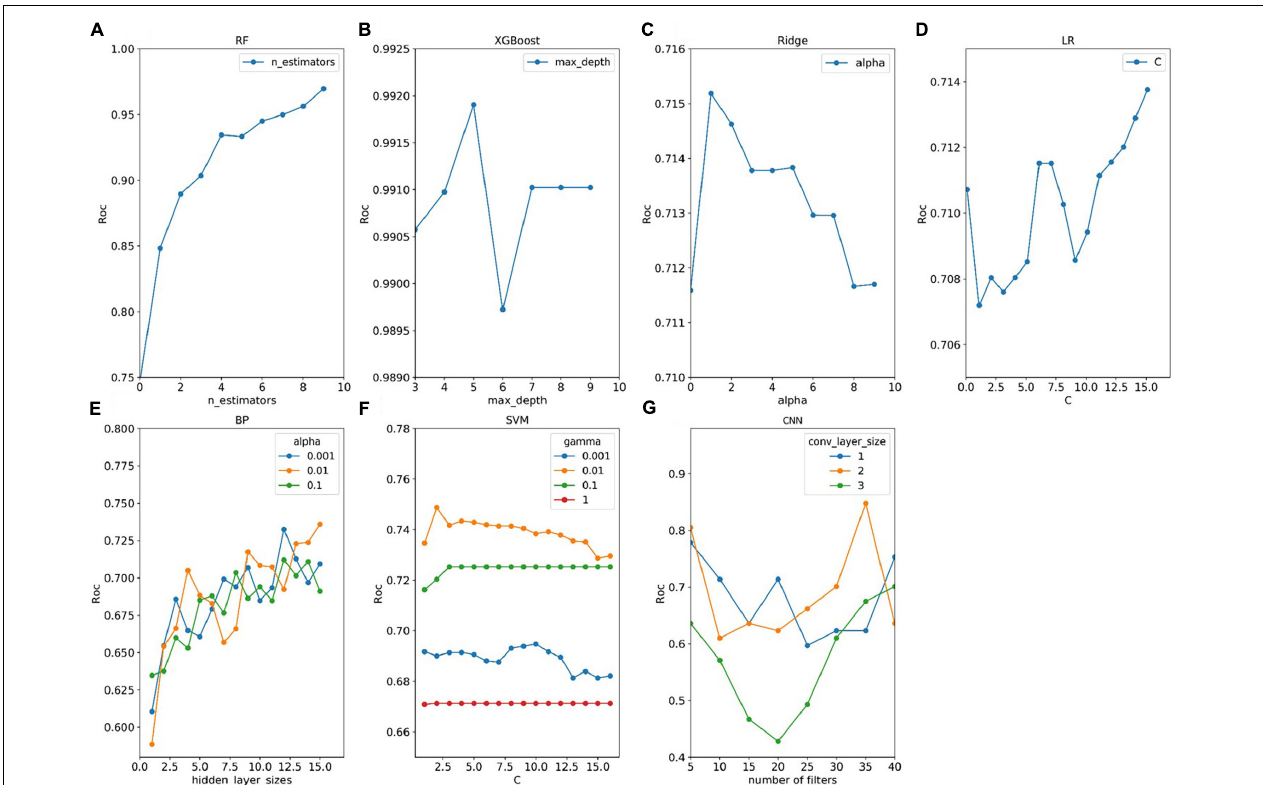
FIGURE 5 | Tuning results of model parameters. (A–G) Four models (RF, XGBoost, Ridge, and LR) have one adjustment parameter, and three models (BP, SVM, and CNN) have two adjustment parameters. For each set of parameters, the model parameters were evaluated for fit using the procedure described in panel Figure 2 . The optimal parameters for each model are selected by obtaining the parameters that the model evaluates to the maximum.